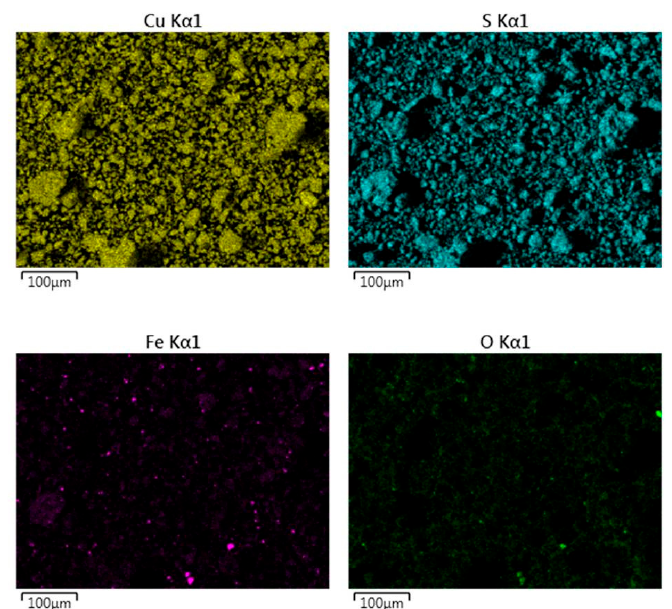
Figure 2. Analysis by scanning electron microscopy with energy dispersive spectroscopy SEM-EDS to